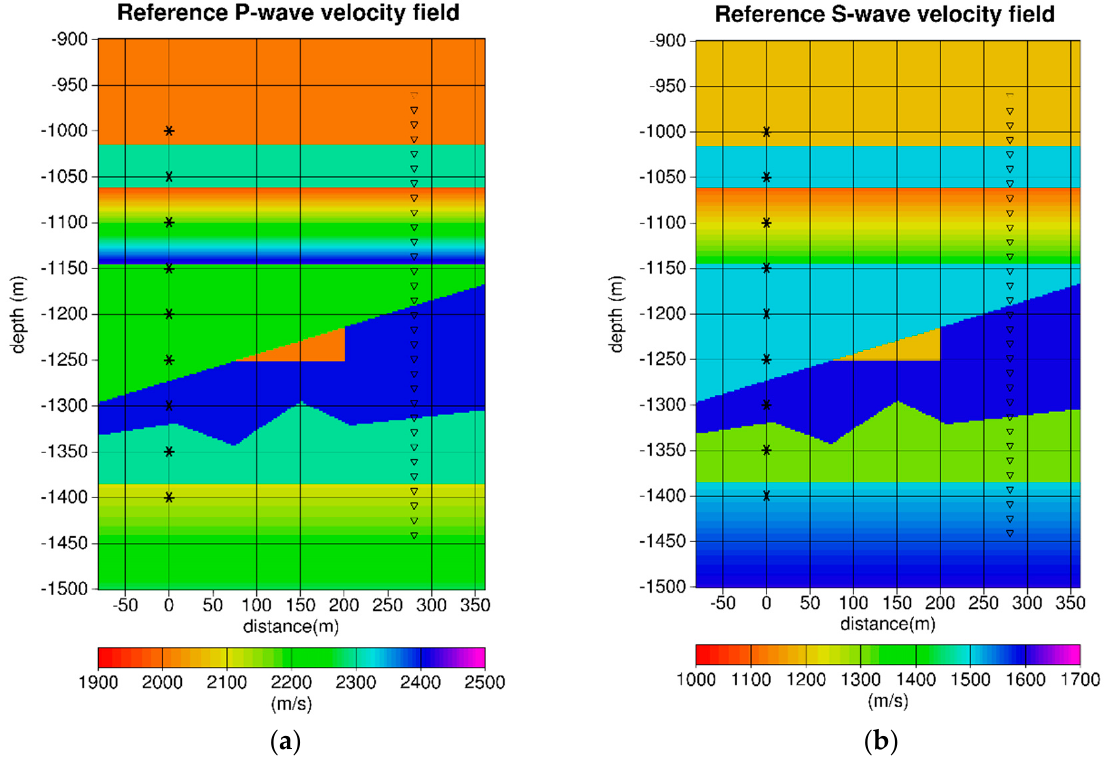
Figure 4. The reference velocity models: ( a ) Reference P-wave velocity field; ( b ) reference S-wave velocity field. The source borehole is located at 0 m distance and the nine asterisks (*) denote the source locations for the nine shots. The receiver borehole is located at 280 m offset and the small triangles denote the locations of the receivers. On can notice that the structures of these reference velocity fields are the same for P- and S-wave. It is composed of 1D regions (invariance along the horizontal axis) in the upper part of the model and at the bottom with homogeneous layers and other layers with a velocity increasing linearly with depth (vertical constant gradient). The middle part of the model exhibits complex 2D structures.